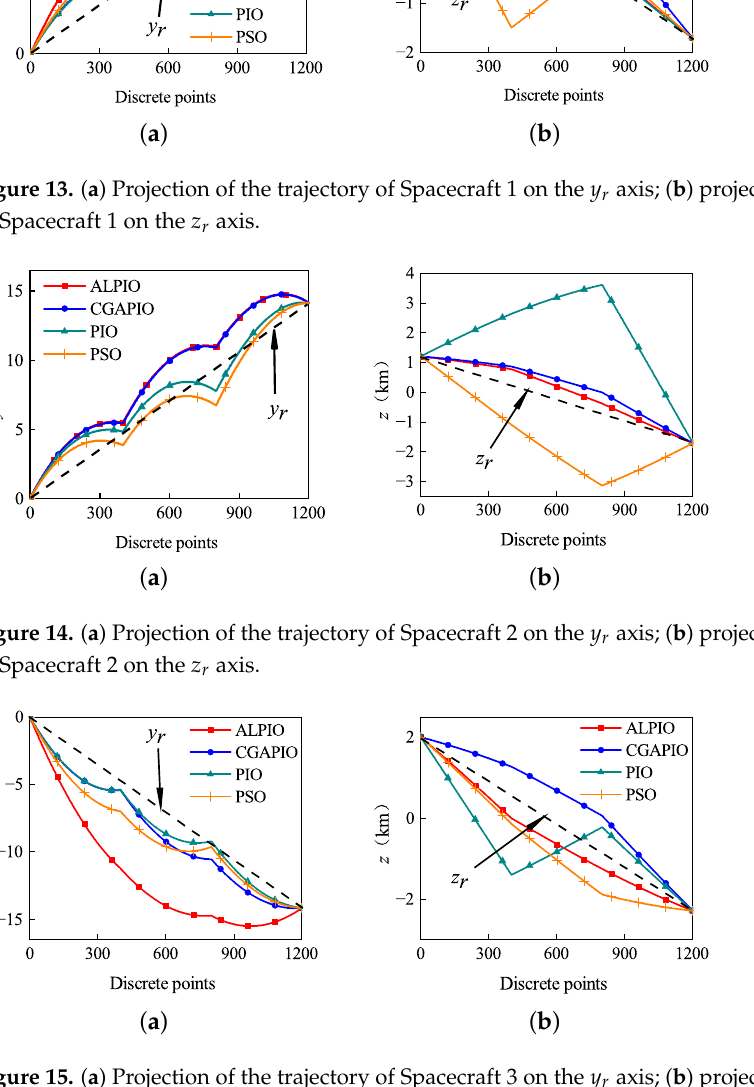
Figure 15. ( a ) Projection of the trajectory of Spacecraft 3 on the y r axis; ( b ) projection of the trajectory of Spacecraft 3 on the z r